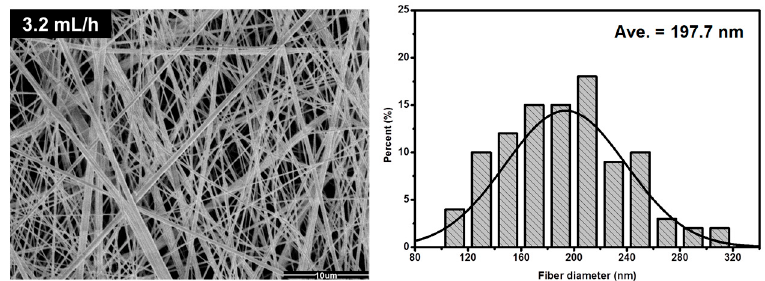
Figure 2. SEM micrographs and diameter distributions of solution blown PAA nanofibers at different feeding rate. PAA concentration, gas pressure, inner nozzle diameter, and receiving distance were fixed as 8 wt %, 0.08 MPa, 0.4 mm and 20 cm, respectively.